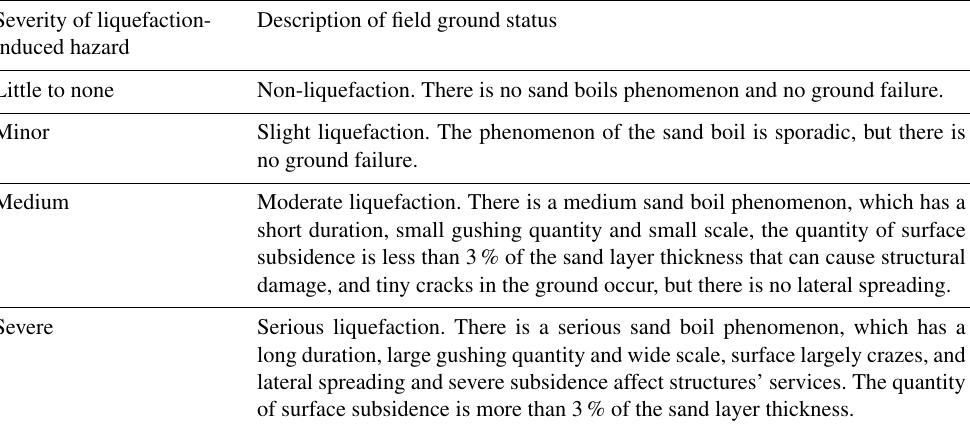
Table 4. Description of the severity of liquefaction-induced hazards. Severity of